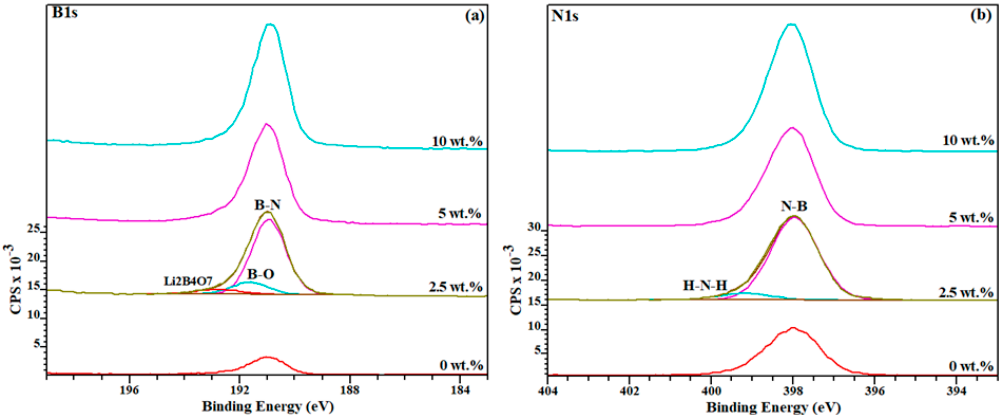
Figure 2. High-resolution XPS spectra showing a deconvoluted peak of ( a ) B1s, and ( b ) N1s for all h BN nanosheet samples after the addition of 0–10 wt% of BaF 2 .